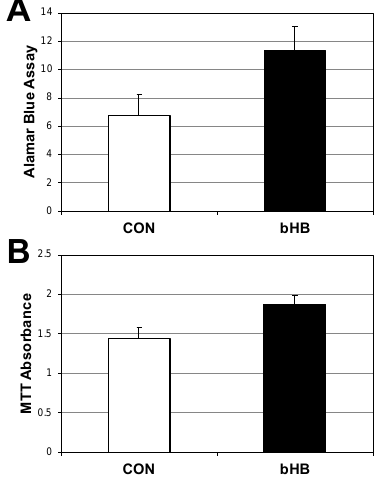
Figure 2. β - Hydroxybutyrate increases myotube viability. Following treatment with PBS (CON) or β - Hydroxybutyrate ( β -HB; 5 mM) for 24 h, myotubes were measured for viability via Alamar Blue ( A ) or with MTT ( B ) to determine metabolic activity. p < 0.05; n = 6.